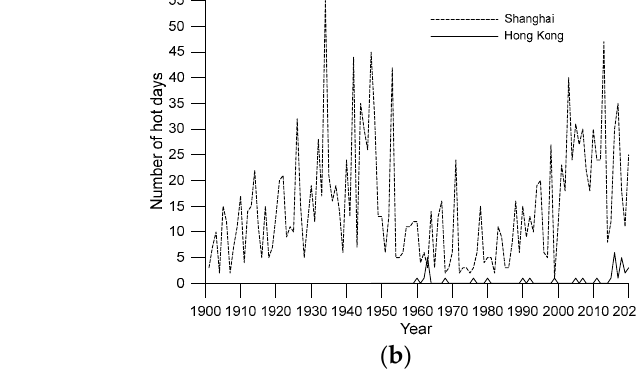
Figure 12. Total numbers of hot days ( a ) and extremely hot days ( b ) for the Shanghai and Hong Kong observatories.